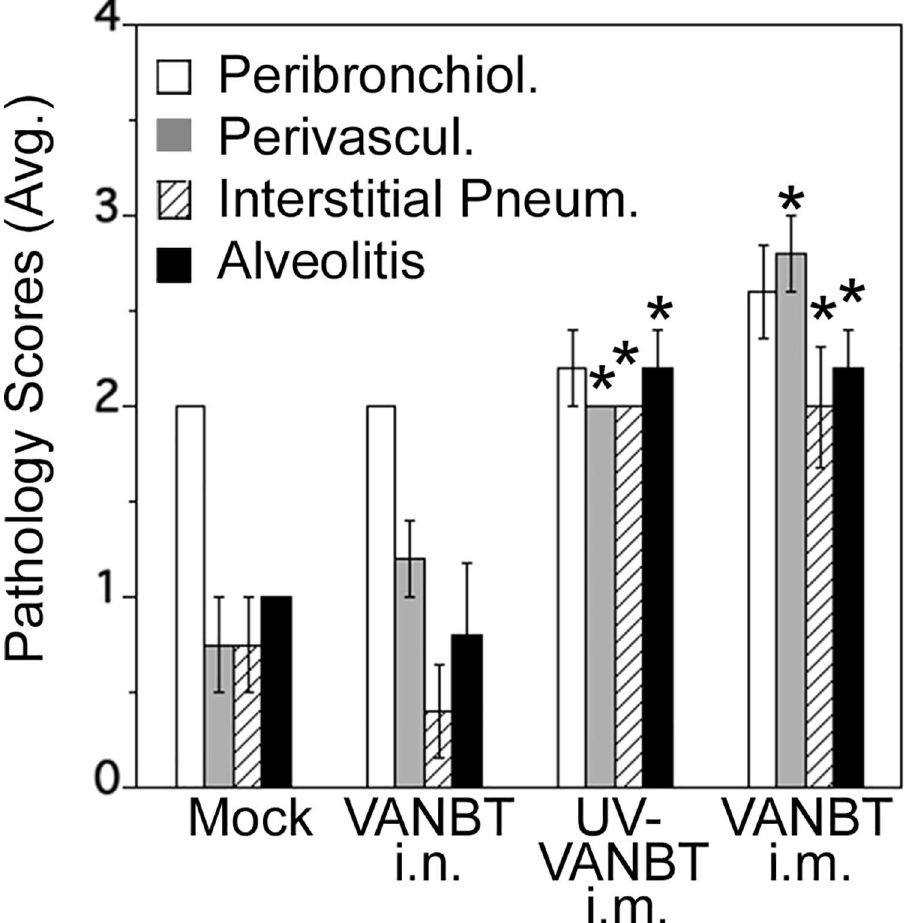
Fig 7. Lung histopathology scores of VANBT-immunized cotton rats upon virus challenge. Groups of female cotton rats were infected or immunized as describedabove for Fig 6. At 7 weeks, all groups were challengedwith VANBT i.n. and sacrificed at 48 h p.i. Graphs represent the average scores for bronchiolitis, vasculitis, interstitial pneumonia, and alveolitis. Results are representative of two independent experiments, n = 5. * p < 0.05 for each group compared with mock immunizedgroup or VANBT/i.n.